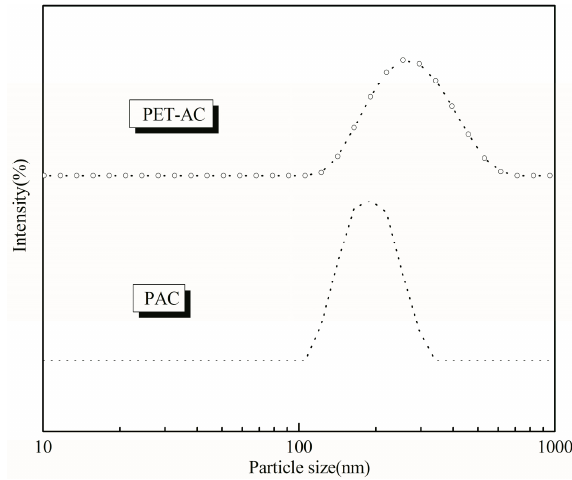
Figure 8. Particle size distribution of latex particles before and after polyester modification.